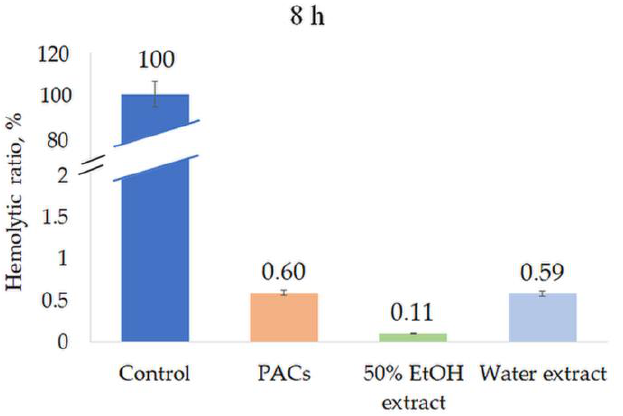
Figure 9. Hemolytic ratio (%) of ‘Maria Bruvele’ twigs’ samples in fresh human blood hemolysis test after 8 h incubation. Control — deionized water, n = 3.